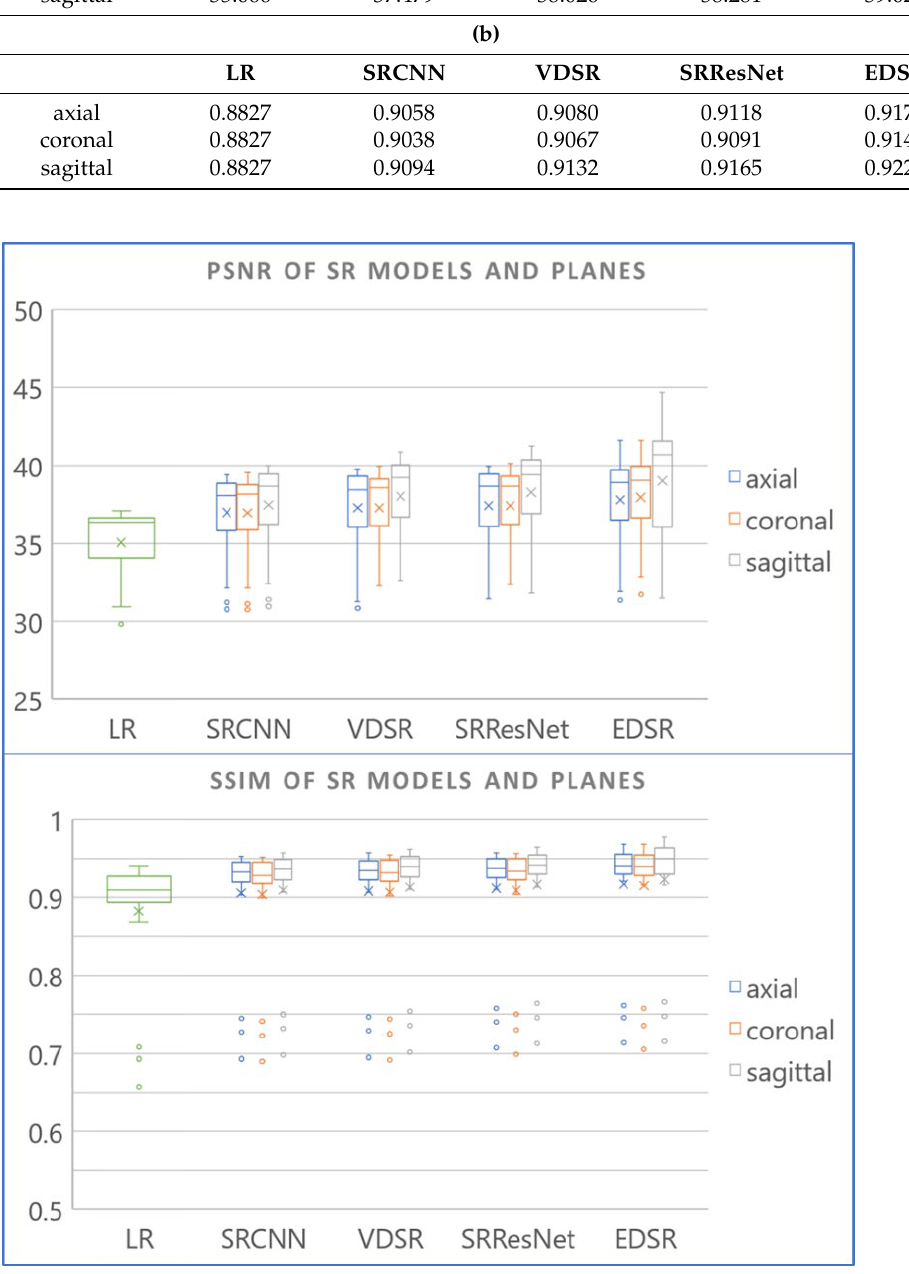
Figure 10. SSIM and PSNR of thin-slice (1 mm) SR CT images with different AI models and planes.